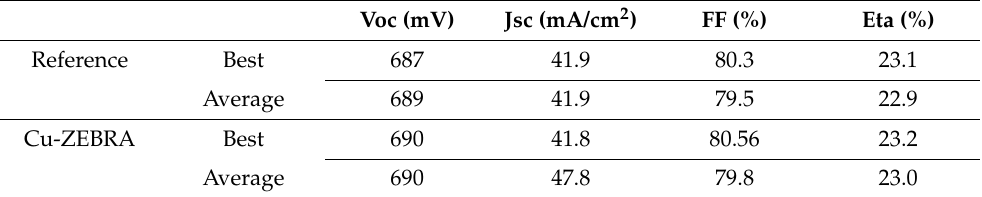
Table 3. IV data of fully Ag-printed (reference) and Cu-printed ZEBRA solar cells with the same geometry (G1 wafer, 4BB) [14].